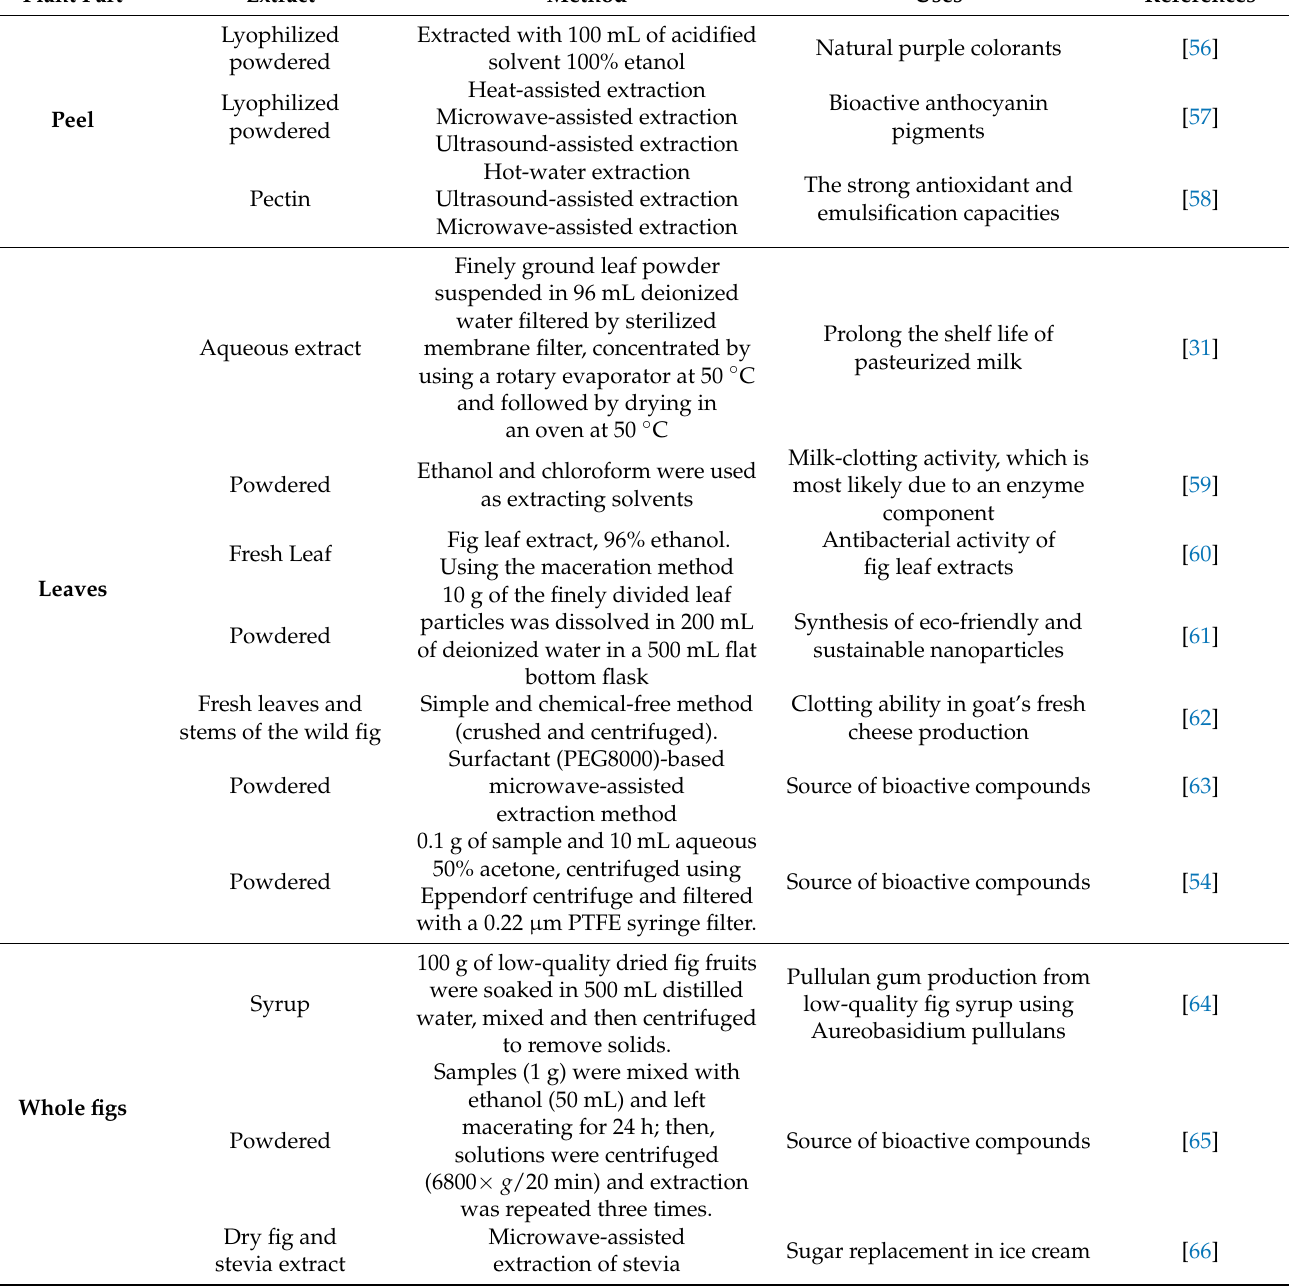
Table 3. Different potential uses of underutilized fruits and extracts of fig by-products. Plant Part Extract